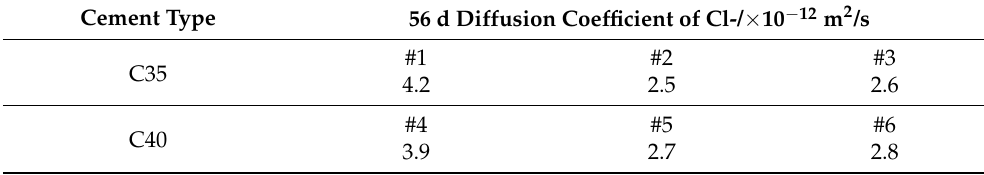
Table 5. Concrete resistance to chloride ion penetration test